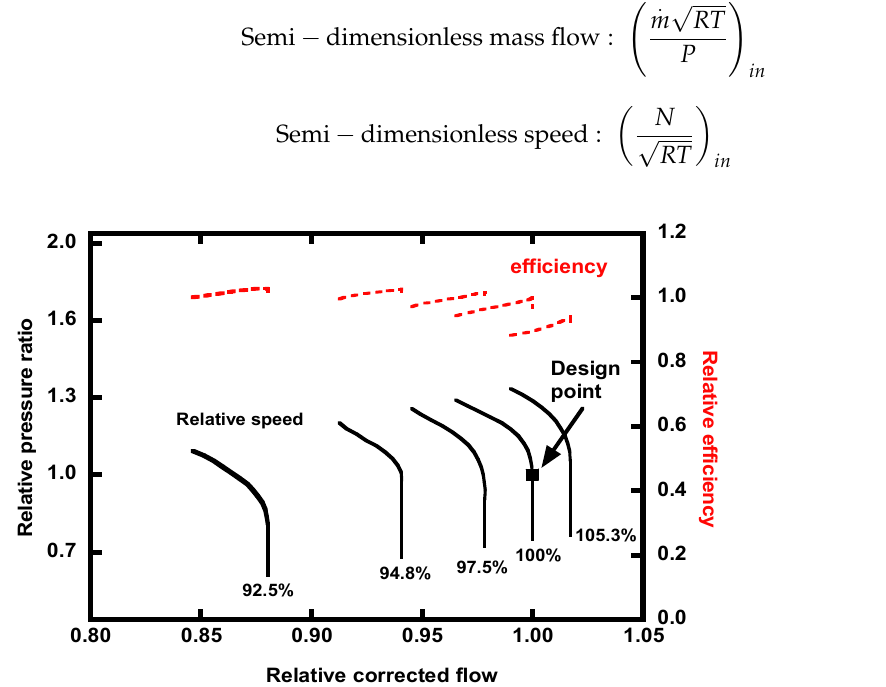
Figure 4. Normalized compressor map.